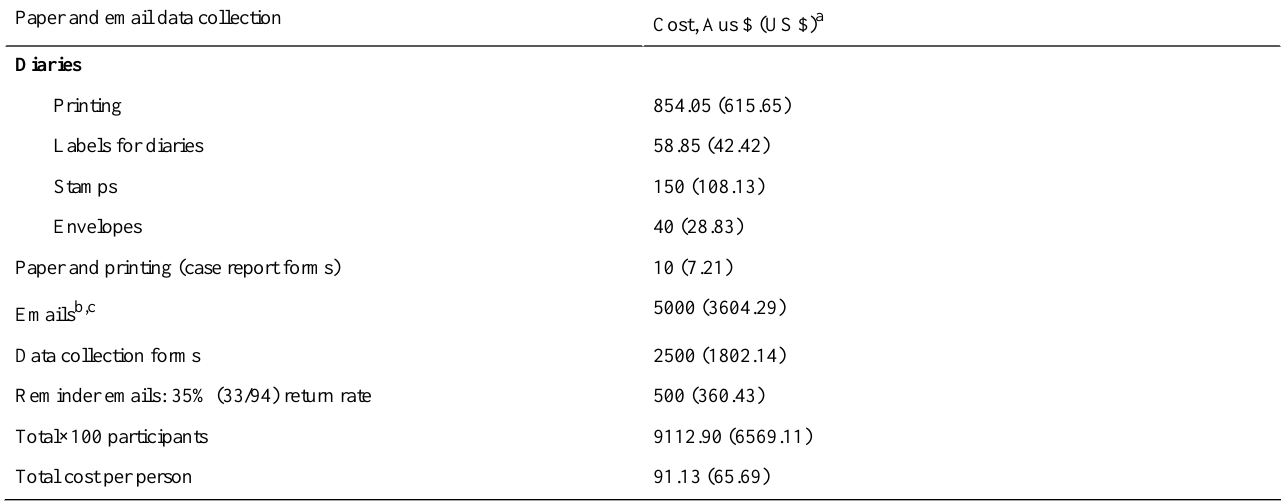
Table 4. Cost analysis for paper and email data collection